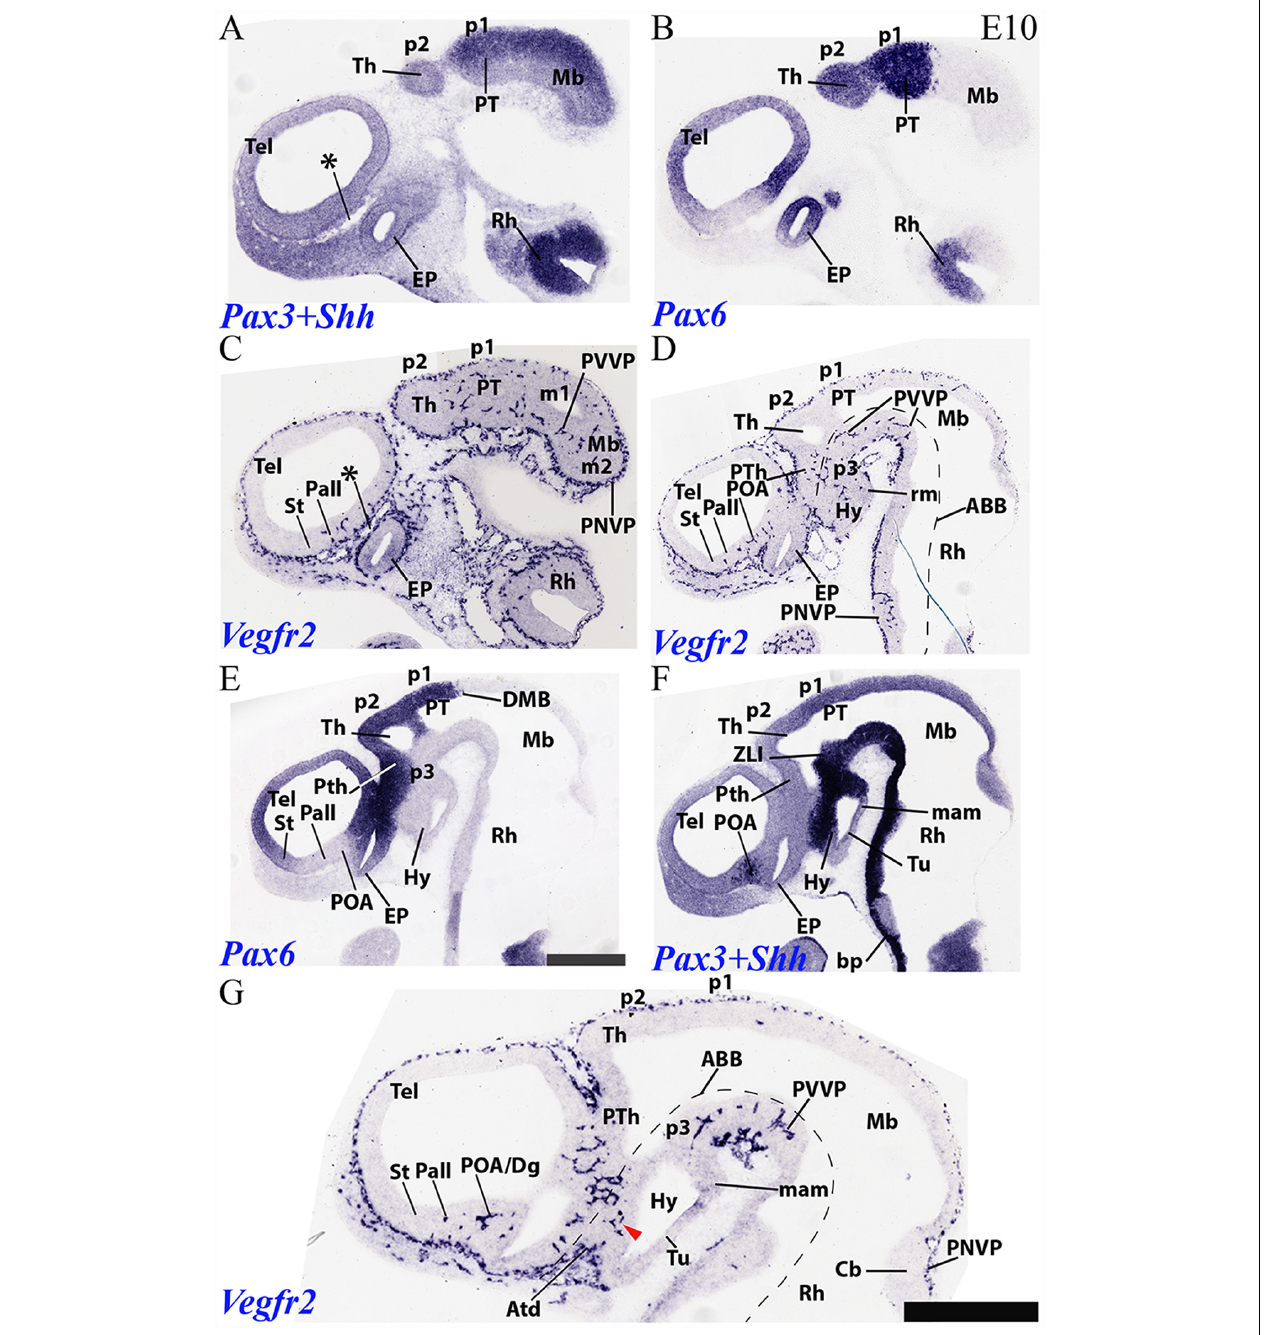
FIGURE 6 | Sagittal sections through a mouse forebrain and hindbrain at E10 (in lateral to medial order) showing PNVP vascularization, perforant vessels and PVVP formation (Vegfr2; C,D,G ), compared in consecutive sections with markers of alar forebrain (Pax6; B,E ) and alar and basal forebrain/hindbrain (Pax3+Shh; A,F ). Red arrow heads: earliest PVs at the dorsal part of the hypothalamic basal plate; note more advanced local alar plate. Asterisks: presumed venous sinuses. See further description in the text. Scale bar: 400 µ